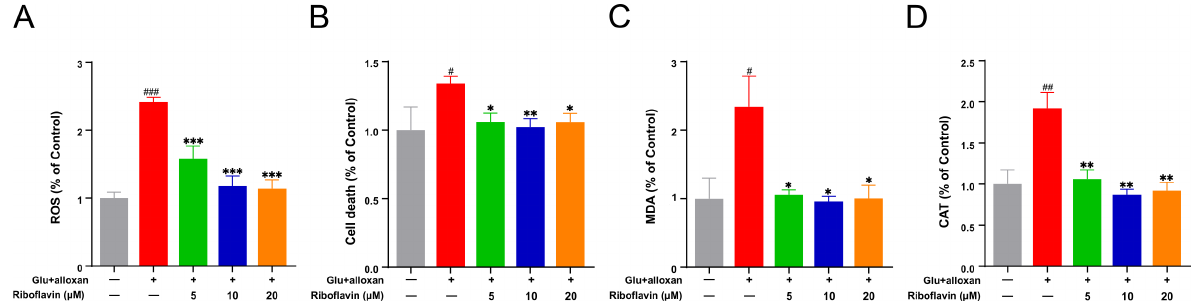
Figure 8. Riboflavin supplementation attenuates oxidative stress in a diabetes zebrafish model. ROS production (( A ), cell death ( B ), MDA levels ( C ) and CAT activity ( D ) in diabetic zebrafish larvae treated with different concentrations of riboflavin. Results are expressed as mean ± SEM. ### p < 0.001, ## p < 0.01, # p < 0.05 vs. control. *** p < 0.001, ** p < 0.01, * p < 0.05 vs. model.